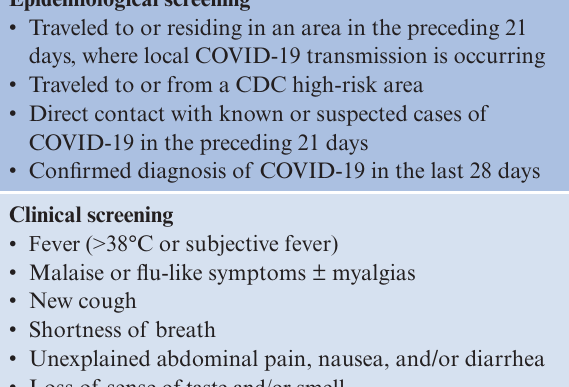
Table 2. Exposure and clinical screening of potential donors with COVID-19.